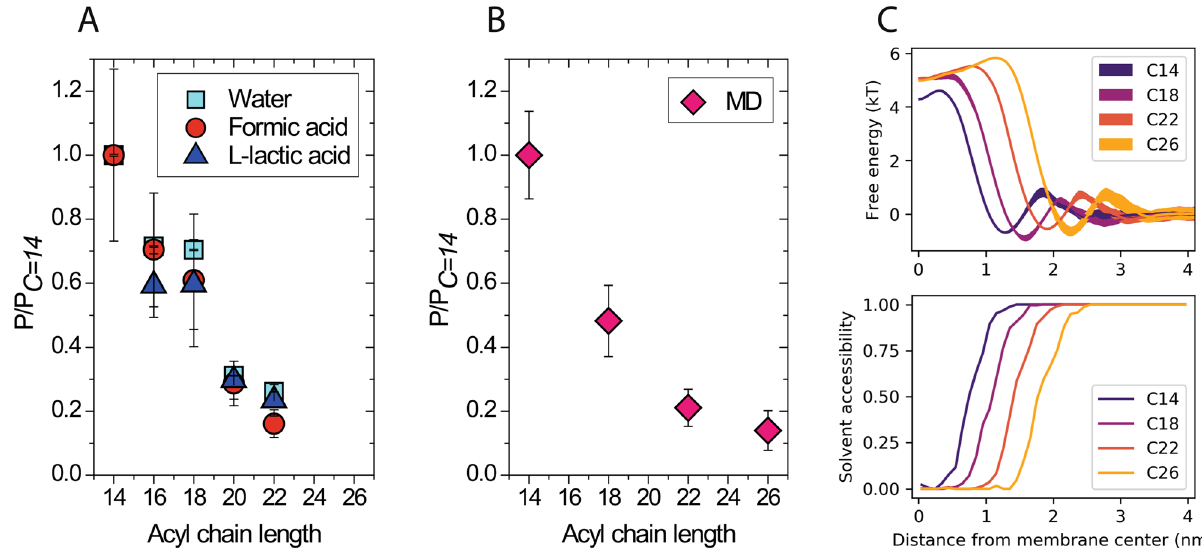
Fig. 2 Permeability of solutes as a function of acyl chain length. Permeability coef fi cients as a function of acyl tail length from experiments at 20 °C ( A ) and simulations ( B ). Lipids with mono-unsaturated tails of lengths between 14 and 26 carbons correspond to 1,2-dimyristoleoyl- sn -glycero-3- phosphocholine (C = 14), 1,2-dipalmitoleoyl- sn -glycero-3-phosphocholine (C = 16), 1,2-dioleoyl- sn -glycero-3-phosphocholine (C = 18), 1,2-dieicosenoyl- sn -glycero-3-phosphocholine (C = 20), 1,2-dierucoyl- sn -glycero-3-phosphocholine (C = 22) and 1,2-dihexacosenoyl- sn -glycero-3-phosphocholine (C = 26), respectively. The level of unsaturation is kept constant (mono-unsaturated tails) for all the analyzed lipids. Solute of the hydrophobic level I was used in the simulations. Permeability coef fi cients are normalized to P C = 14 , which in the experimental analysis corresponds to 22.8 (±1.9) × 10 − 3 cm/s, 11.80 (±1.43) × 10 − 3 cm/s, and 0.332 (±0.052) × 10 − 3 cm/s for water, formic acid, and L-lactic acid, respectively. Data are presented as mean values ± SEM. Error estimates represented by error bars around the mean values are described in “ Methods ” ( “ Fit of the in vitro kinetics ” for experimental data, “ Inhomogeneous solubility-diffusion model ” , for MD simulations). The numerical values are presented in Supplementary Table 2. C Free energy (top) and solvent accessibility (bottom) pro fi les from simulated membranes of variable thickness. The uncertainty of the free energy pro fi les is represented by the thickness of the lines. Longer acyl chain length of the phospholipid tails increases the membrane hydrophobic thickness (Supplementary Fig. 2), which leads to an increasingly wider and higher free energy pro fi